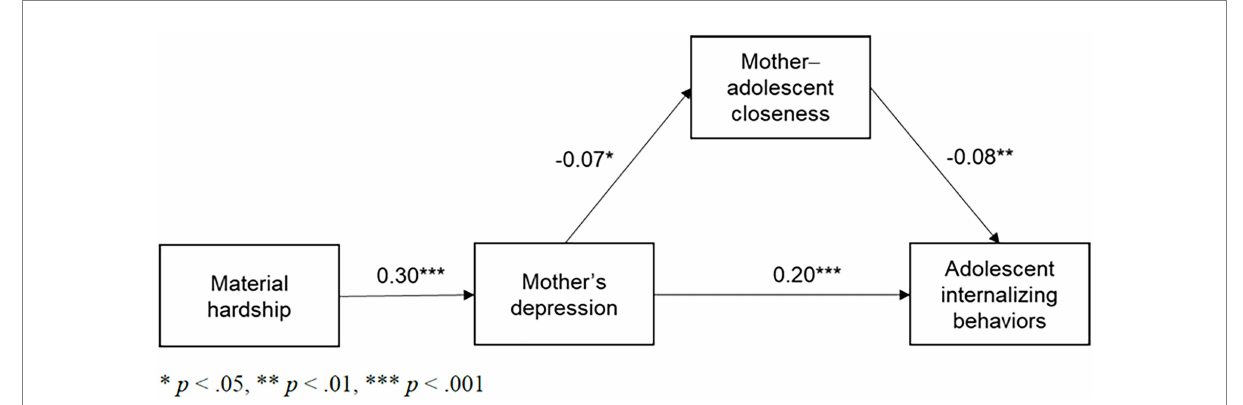
FIGURE 2 SEM path model from material hardship to adolescents’ internalizing behaviors